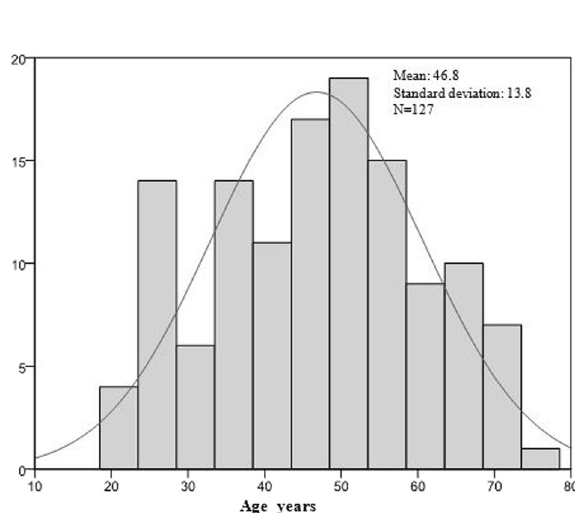
Fig. 2 Age distribution. Showing a peak around the age of 50.